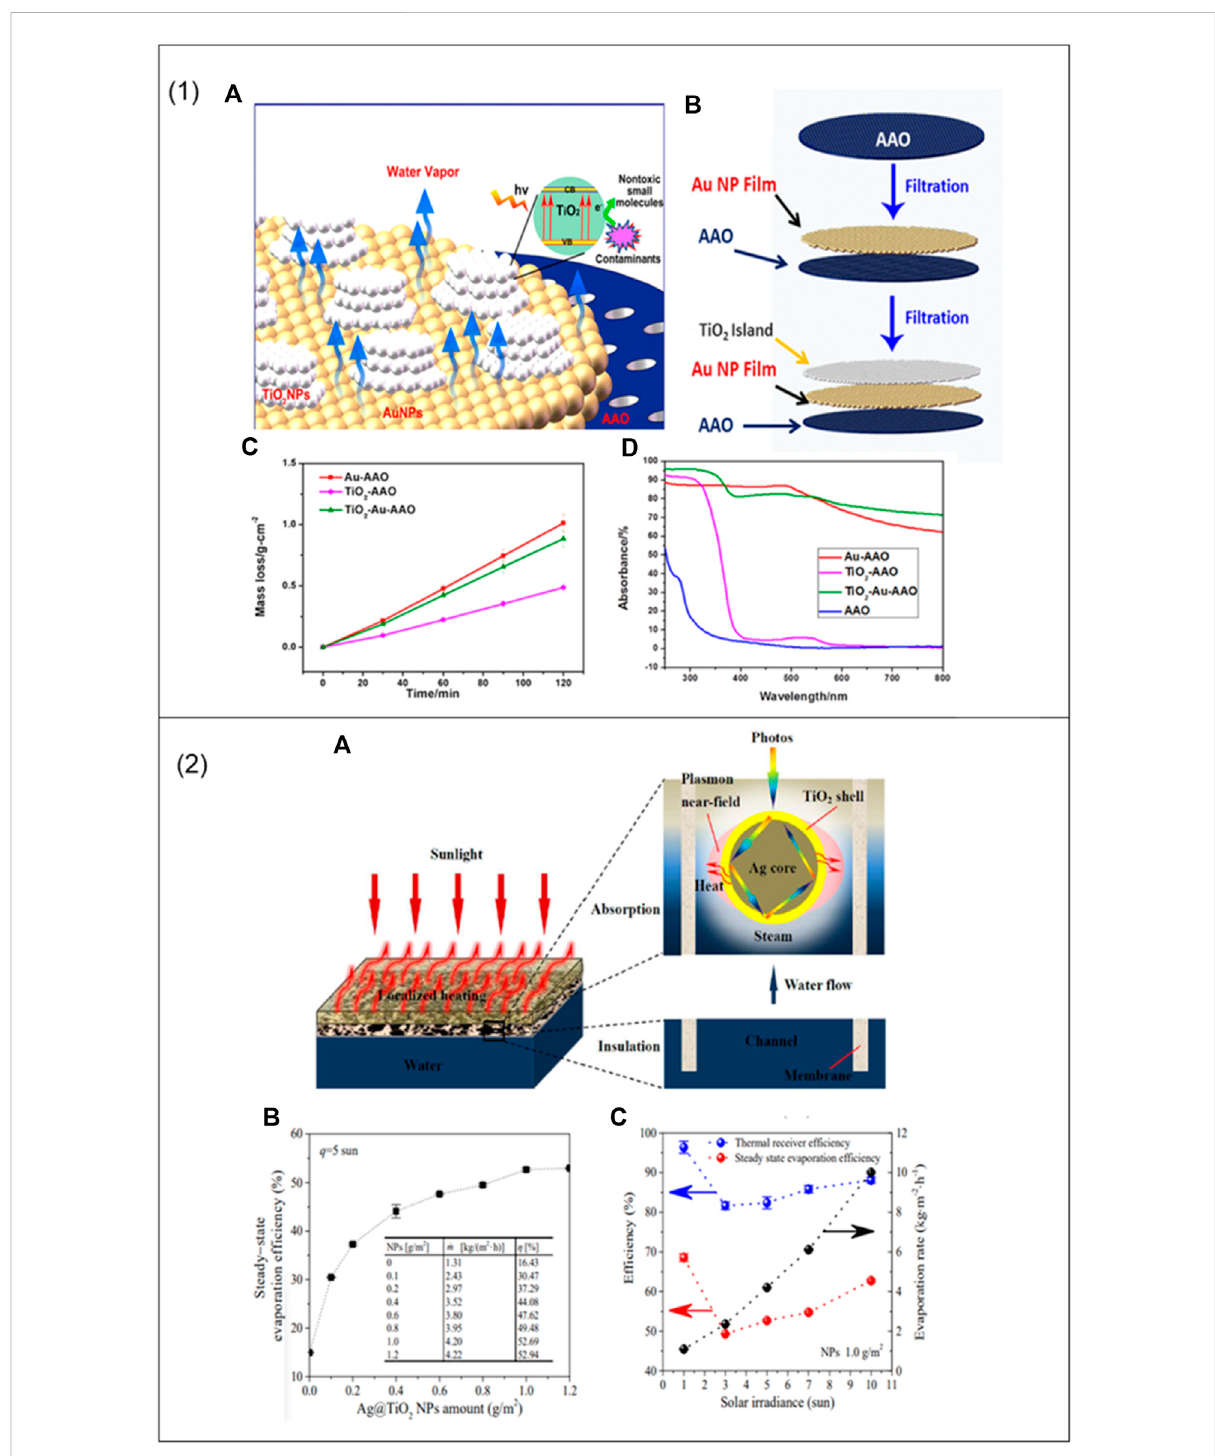
FIGURE 7 (1) (A) Structure of three layers incorporated into a bi-functional photo-thermal TiO 2 -Au-AAO membrane. (B) Demonstration of a bifunctional membrane. (C) Evaporationof differentsamplesinthe presence ofsimulated solar light. (D) Absorptionspectra of differentsamples(Liuetal., 2016); Reproduced with permission. Copyright 2016 American Chemical Society. (2) (A) Illustration of a schematic of the photo-thermal conversion process. (B) Evaporation ef fi ciency with Ag@TiO 2 NP amounts. (C) Evaporation rate, evaporation ef fi ciency, and thermal receiver ef fi ciency under steady-state conditions as functions of solar irradiance (Li et al., 2017b); Reproduced with permission. Copyright 2017